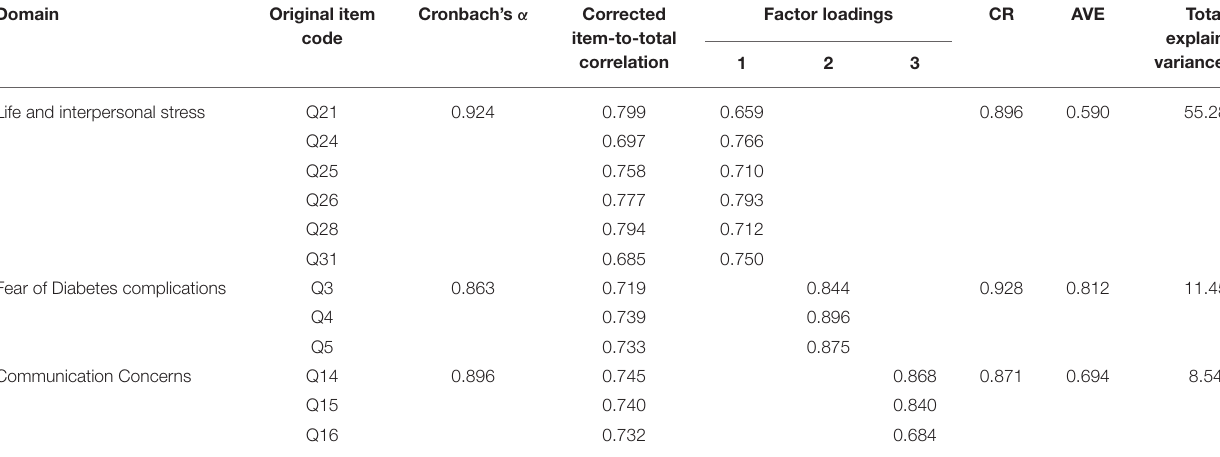
TABLE 3 | Factor loading for 12-items diabetes distress scale ( N =